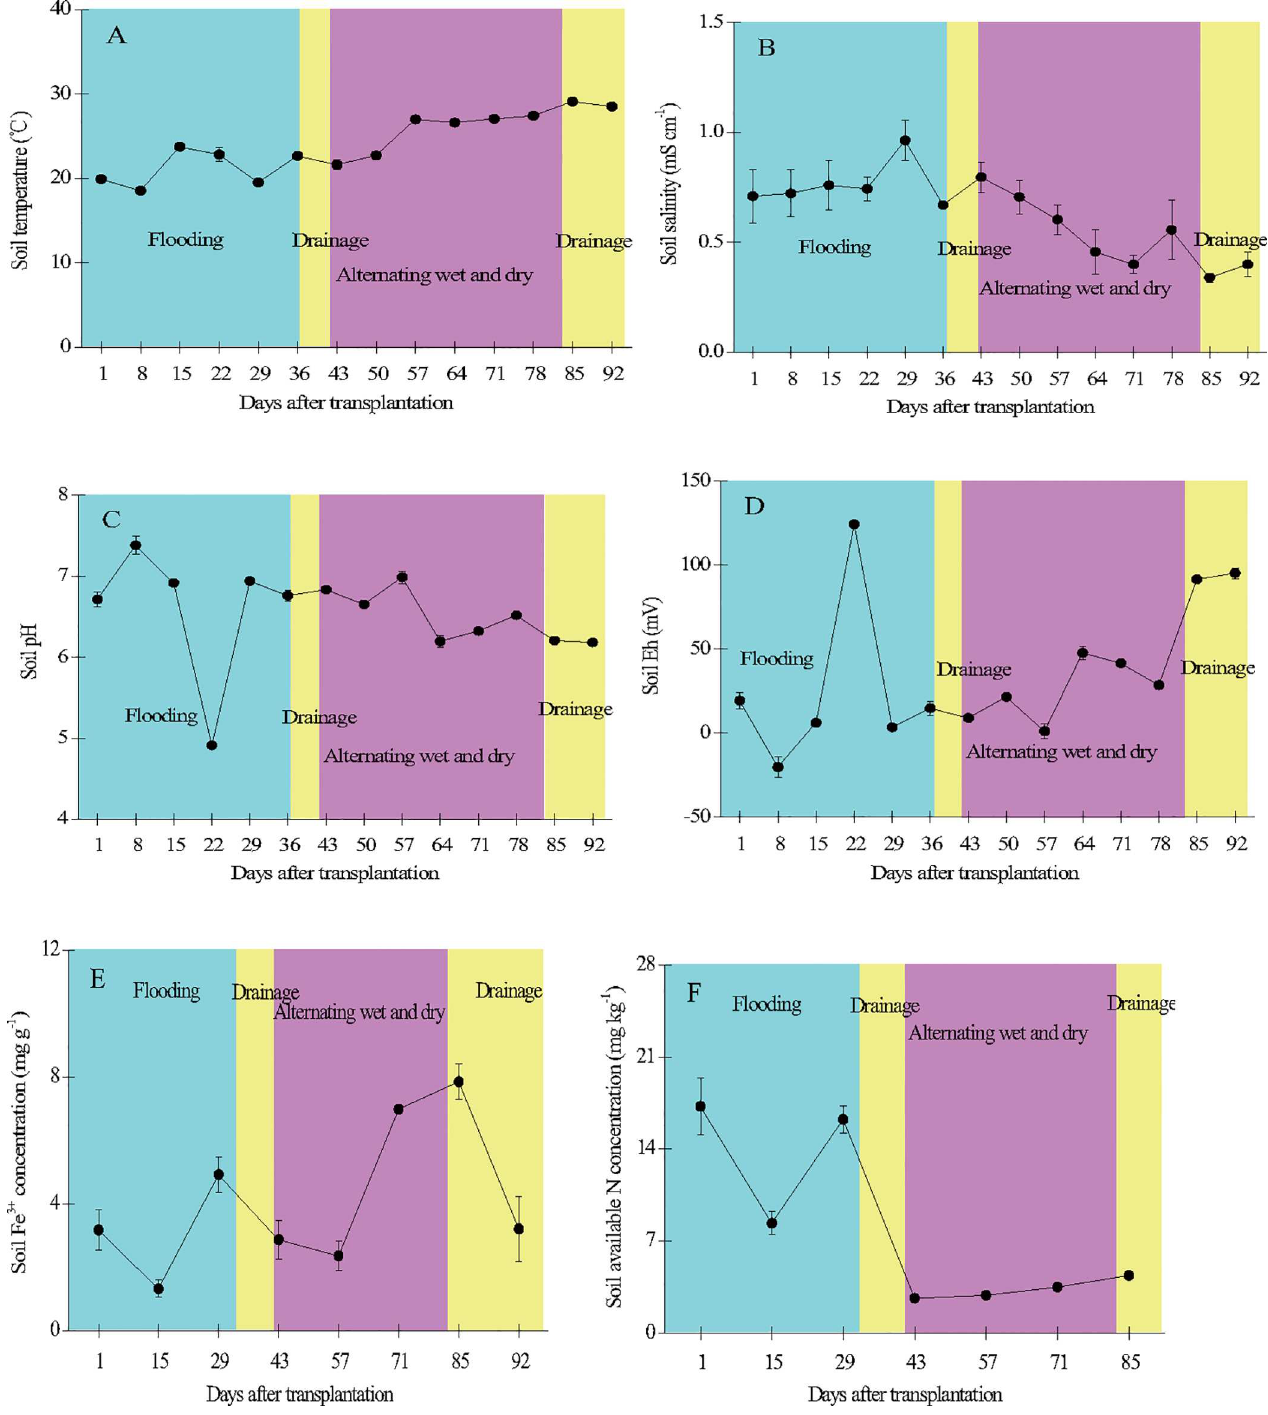
Fig 5. Temporal variationof soil temperature (A), soil salinity (B), pH (C), Eh (D), and Fe 3+ (E) and availableN (F) concentrations in the paddyfield. Error bars indicate the standarderror of the mean of triplicate measurements.